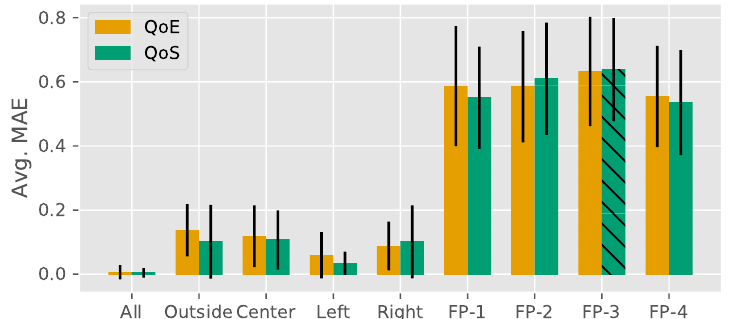
Figure 4. Mean Absolute Errors (MAE) for the regular image (AR) condition averages and standard deviations for subject ratings (QoE) and impairment level (QoS) prediction performance analysis of individual subjects.